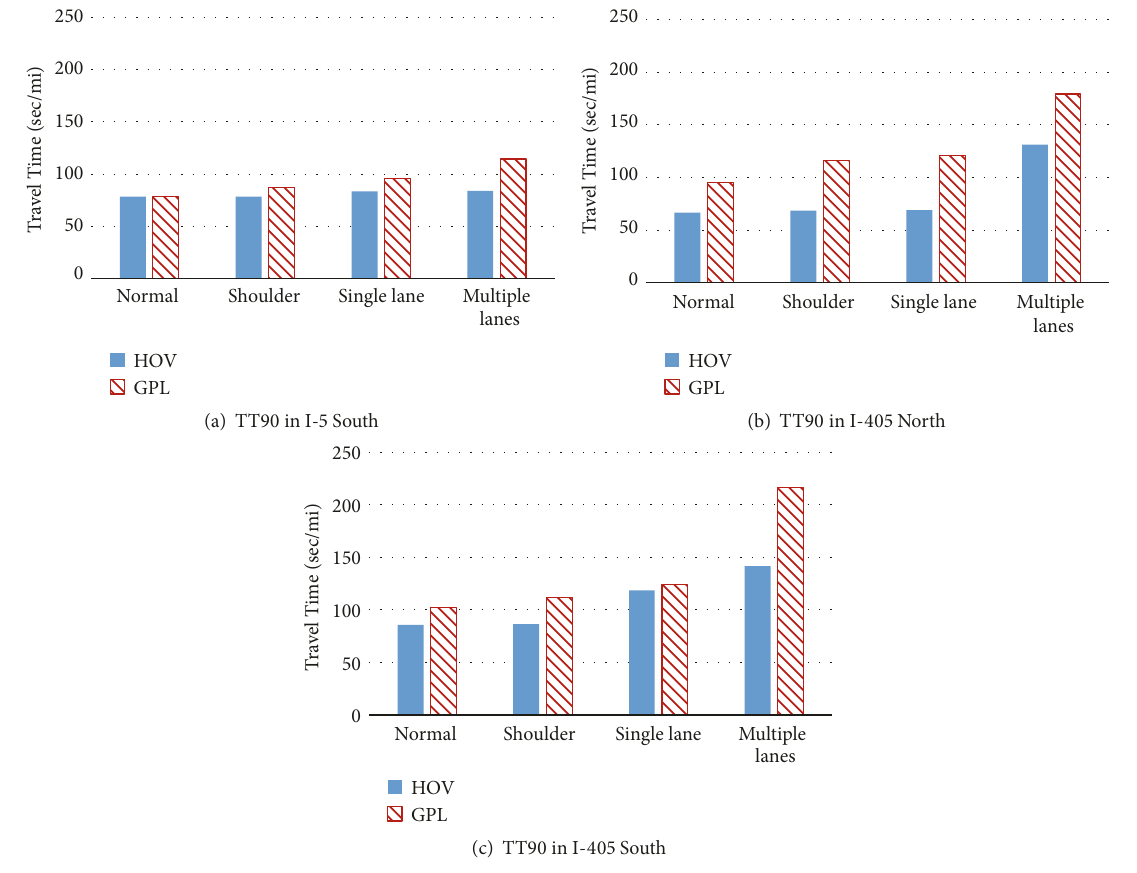
Figure 4: Comparison of 90th percentile travel time between HOV lanes and GPLs on I-5 South, I-405 North, and I-405 South. (a) TT90 in I-5 South. (b) TT90 in I-405 North. (c) TT90 in I-405